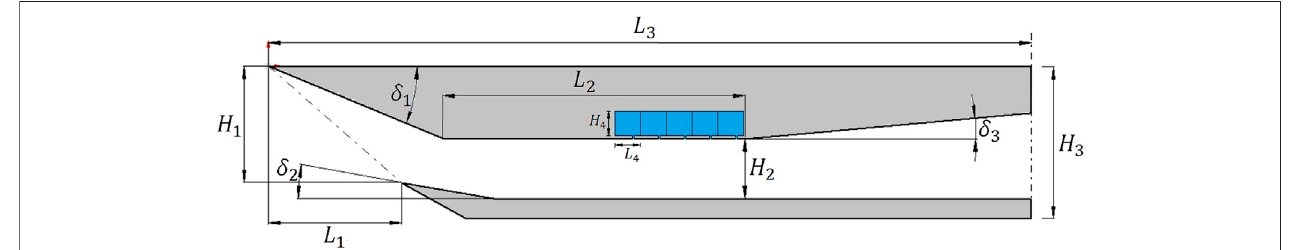
FIGURE 1 | Schematic of the calculation model.